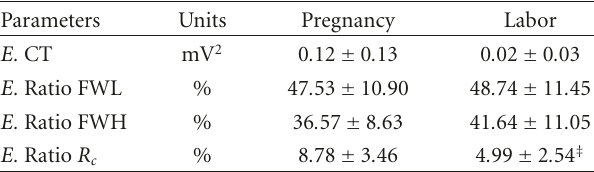
Table 3: Comparison of energy ( E ,) parameters between pregnancy and labor contractions ( † and ‡ indicate a significant di ff erence of 5% and 1%, respectively, between pregnancy and labor parameters).